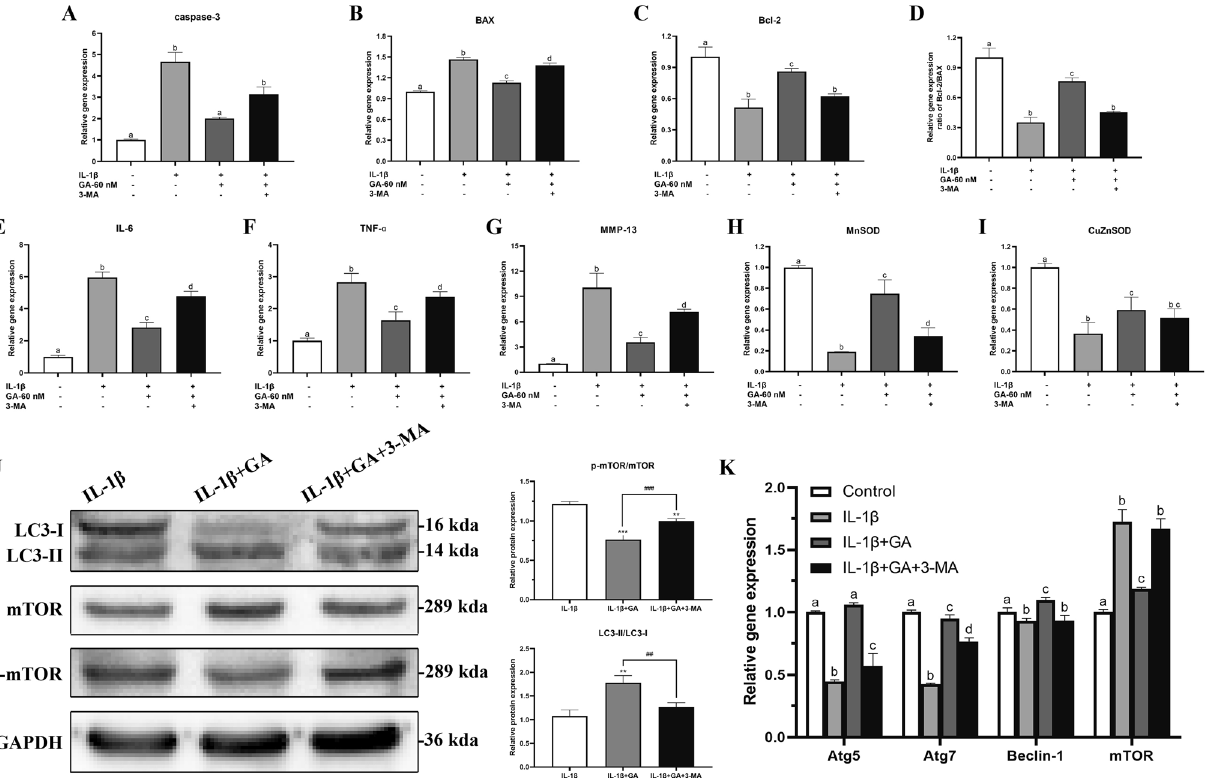
Figure 5. Effect of His6-GABARAP on the treatment of IL-1β-induced BMSCs. (A-I, and K) qRT-PCR was used to analyze the gene expression levels of caspase-3, BAX, Bcl-2, Bcl-2/BAX ratio, TNF-α, IL-6, MMP-13, MnSOD, CuZnSOD, Atg5, Atg7, Beclin-1, and mTOR in vitro. (J) Western blot was used to analyze the protein expression of LC3, mTOR, and p-mTOR. Values are presented as means ± SD, n = 3. Bars with different letters are significantly different from each other at p < 0.05 and those with the same letter exhibit no significant difference. ** p < 0.01, *** p < 0.001 relative to the IL-1β group; ## p < 0.01, ### p < 0.001 relative to the IL-1β + GA